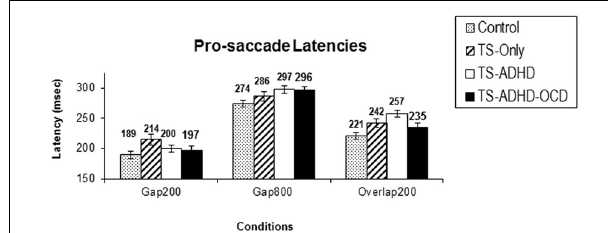
FIGURE 1 | The graph depicts the mean prosaccade latencies of the groups: Control, Tourette-only (TS-only), Tourette Syndrome + Attention Deficit Hyperactivity Disorder (TS + ADHD) and Tourette Syndrome + Attention Deficit Hyperactivity Disorder + Obsessive Compulsive Disorder (TS + ADHD + OCD). It shows the expected observation of longer saccadic latencies in a long Gap condition (Gap800) relative to an Overlap (Overlap200) condition. Error bars indicate standard errors.